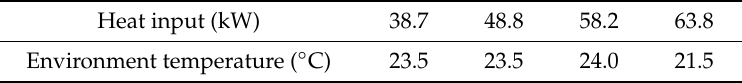
Table 5. The environment temperature for using the plunger pump.